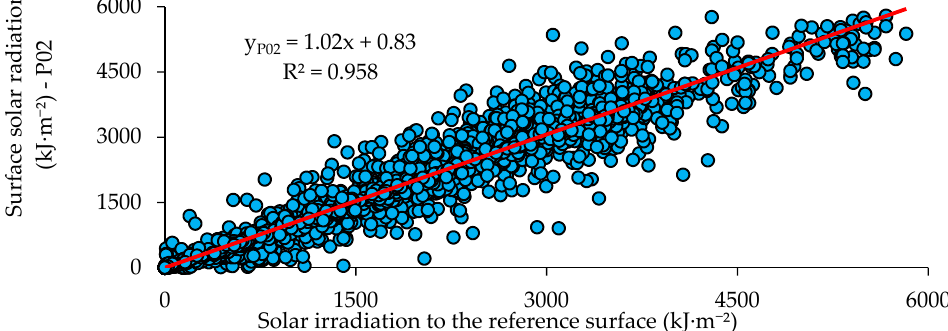
Figure 14. Scatter graph between the reference surface solar radiation (INMet) and the response of prototype P02 for Campina Grande, Brazil.